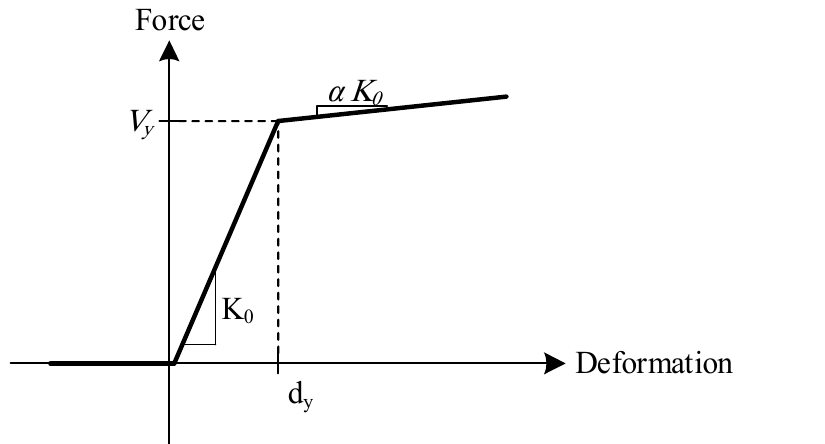
Figure 6. Tension strip layout for the modeling of the SPSW developed by Vian et al. [32].